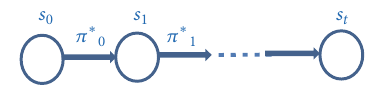
Figure 8: Policy decision